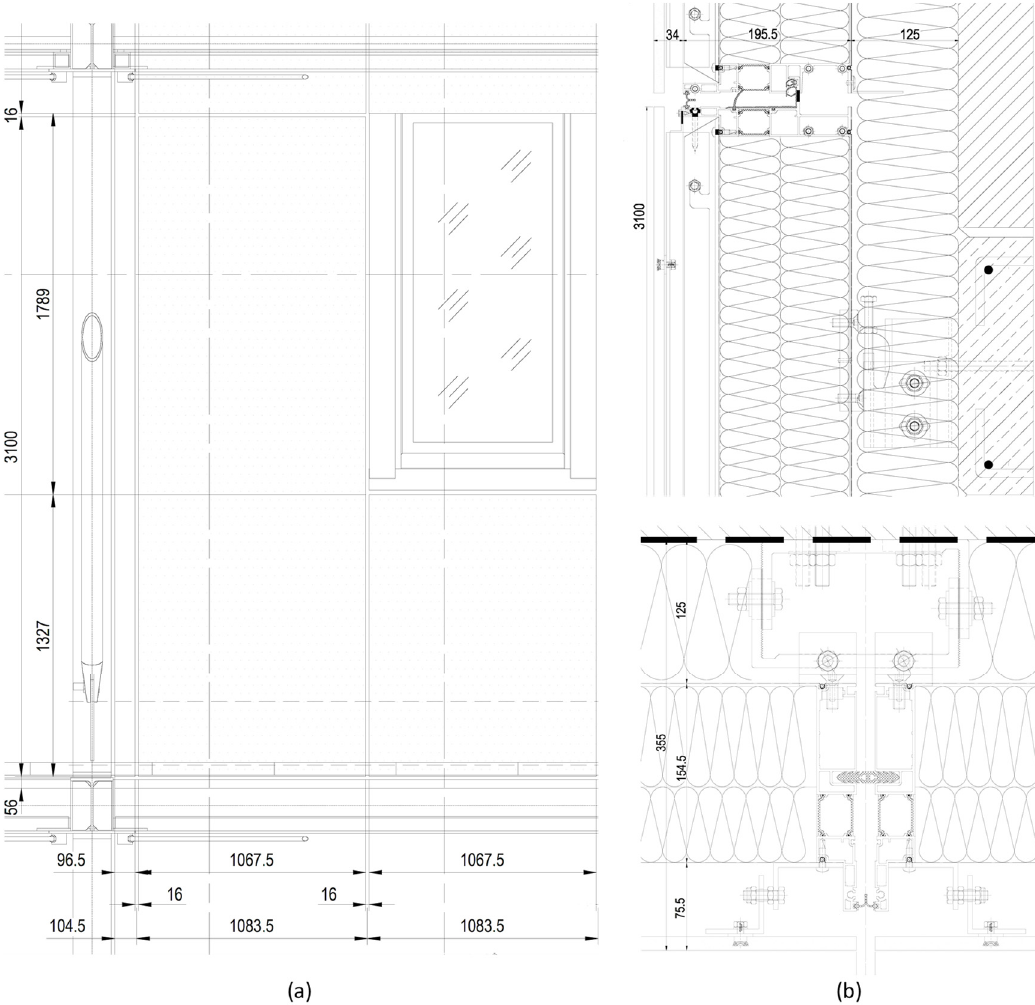
Figure 2. ( a ) Elevation; ( b ) detailed sections of the plug and play façade module (measurements in mm).